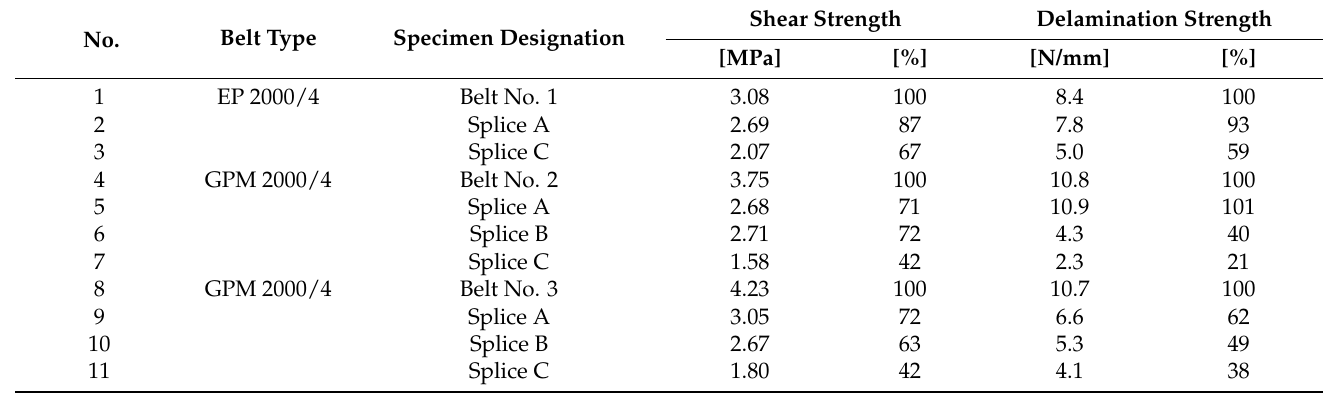
Table 5. Splice shear and delamination strength test results.